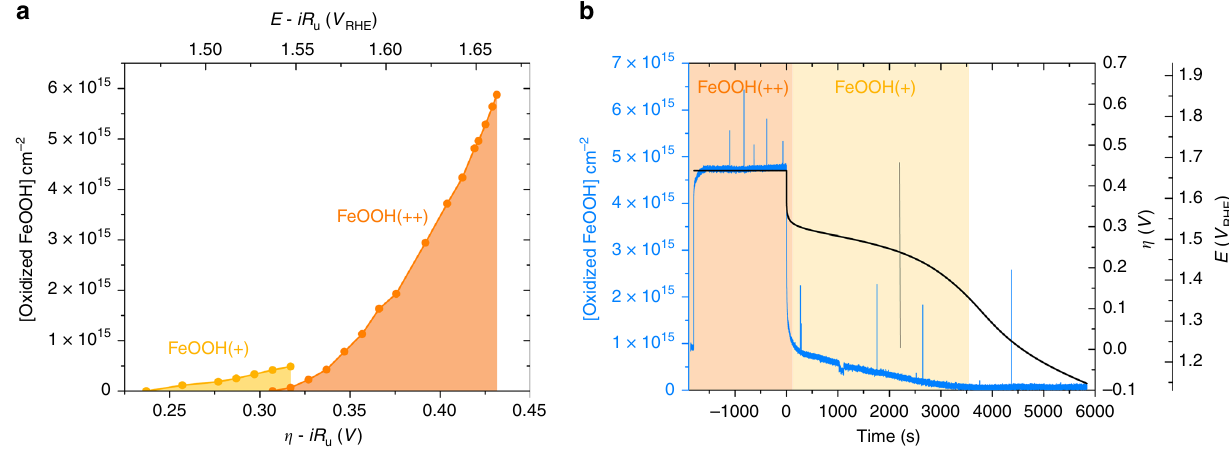
Fig. 3 Accumulated FeOOH( + ) and FeOOH( ++ ) species with applied potential. a Accumulated FeOOH( + ) (yellow) and FeOOH( ++ ) (orange) concentrations vs. overpotential. b Simultaneous measurement of the 500 nm optical signal (blue trace), expressed as concentration, and electrode potential (black trace) induced by the application of a 0.44 V overpotential to FeOOH, and then switching to